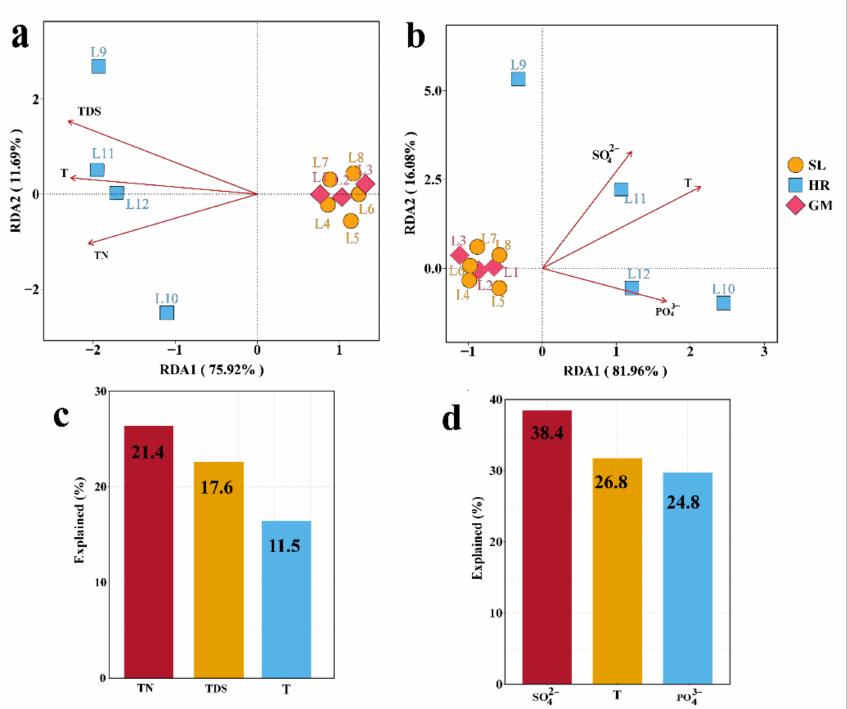
Figure 5. Redundancy analyses (RDA) show the influence of significant environmental factors on ( a ) bacterial community composition and ( b ) bacterial functional composition. Bar plots ( c , d ) presenting the variation explained by each factor are shown below the RDA; SL: subsidence lakes; GM: coal gangue mountain waters; HR: Huihe